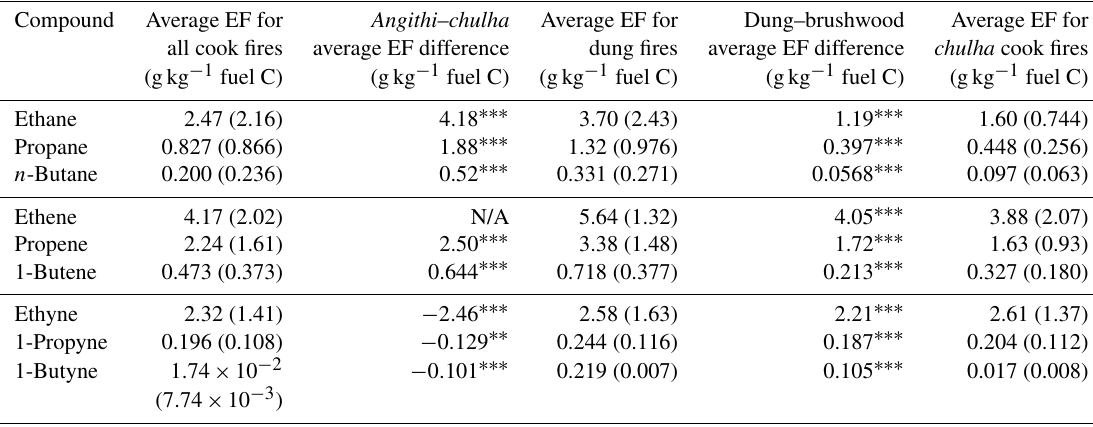
Table 2. Emission factors (gVOCkg − 1 fuel C) for select compounds. The mean differences between dung– angithi and dung– chulha are shown and similarly for dung– chulha and brushwood– chulha . The significance between fuel or stove and EF is indicated with asterisks. Accompanying the mean differences is the average emission factor (gVOCkg − 1 fuel C) for dung cook fires and chulha cook fires, as well as the overall average for all performed cook